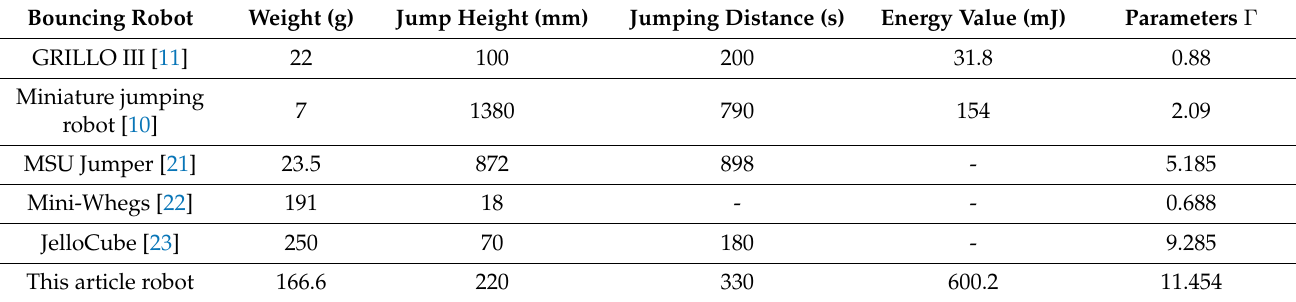
Table 3. Comparison of the characteristics of miniature bouncing